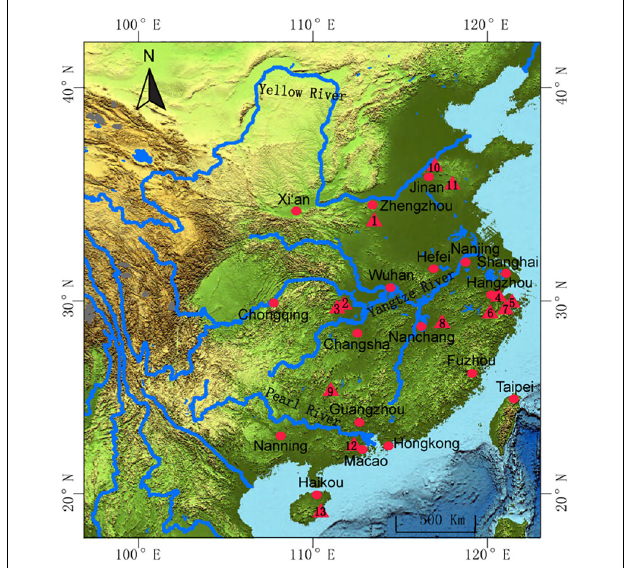
FIGURE 2 | Map showing important sites related to this study. (1) Jiahu, (2) Bashidang, (3) Pengtoushan, (4) Kuahuqiao, (5) Hemudu, (6) Shangshan,